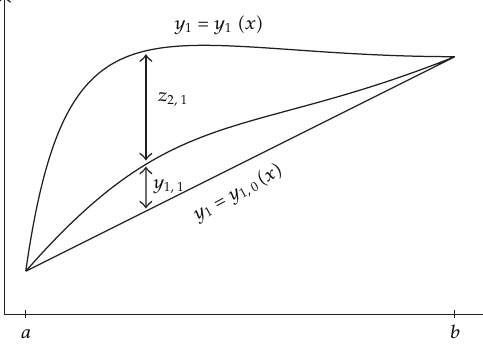
Figure 3: Geometric representation of the functions z 2 , 1